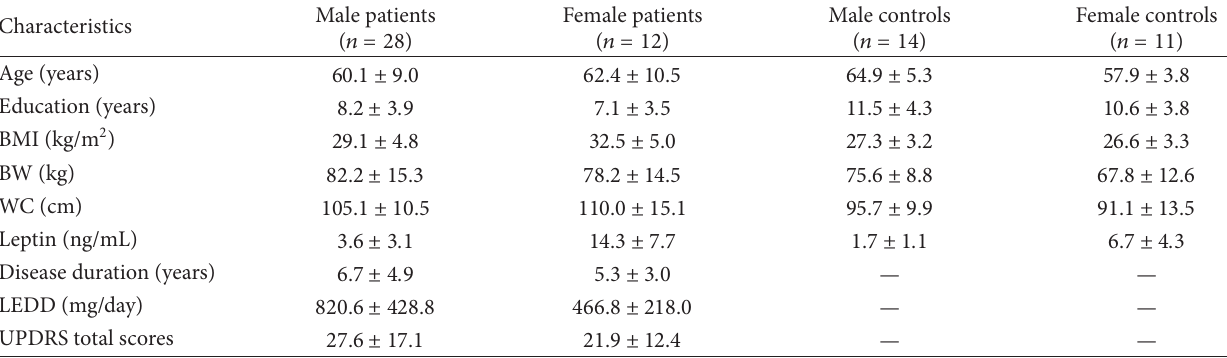
Table 1: Sociodemographic and clinical characteristics of male and female PD patients and controls. Characteristics